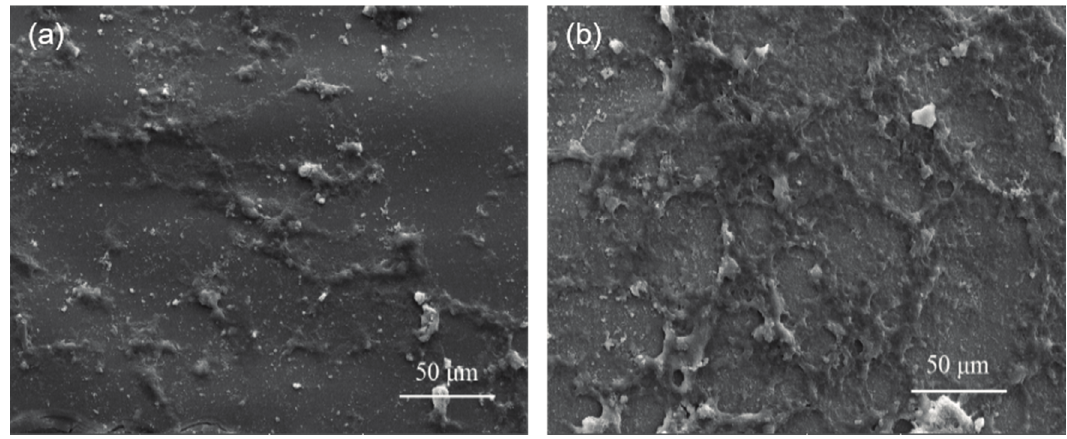
Figure 6. MG-63 cells cultured on Di scaffolds for ( a ) 3 days; and ( b ) 7